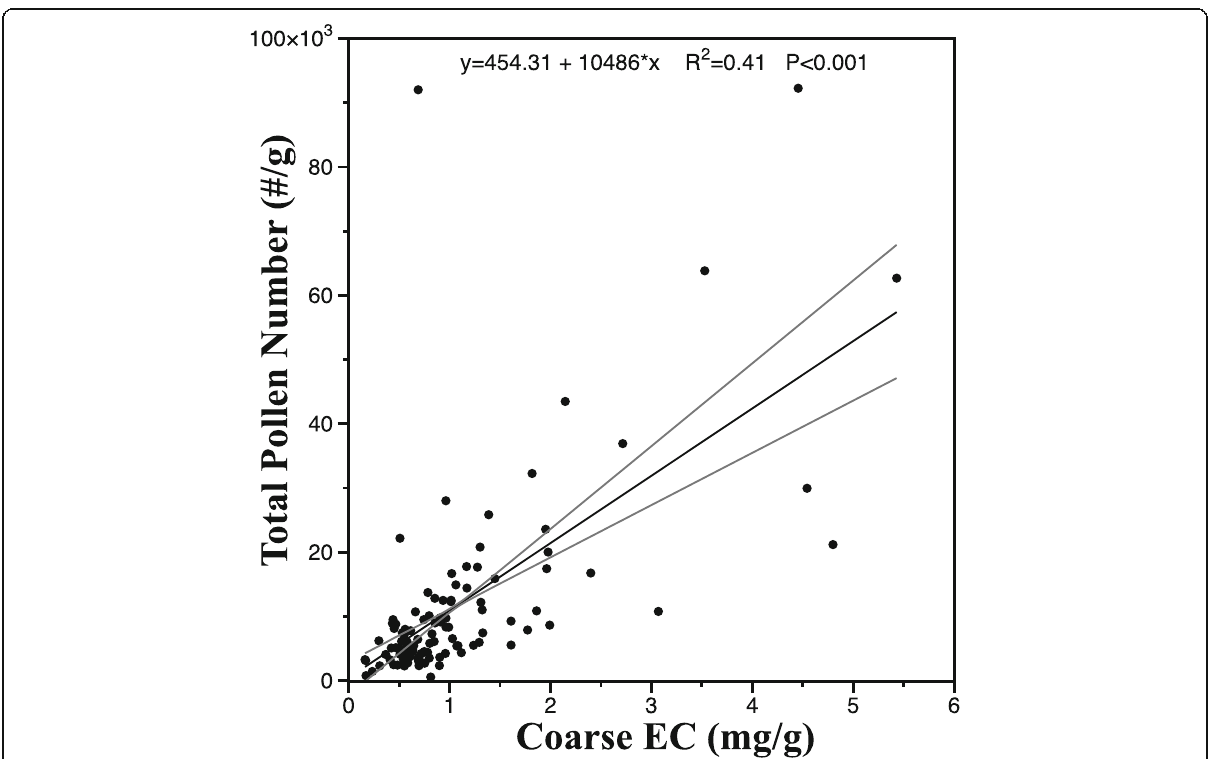
Fig. 6 Relationship between pollen content and EC content in the coarse fraction at site U1423. The gray lines represent the 95% of confidence interval